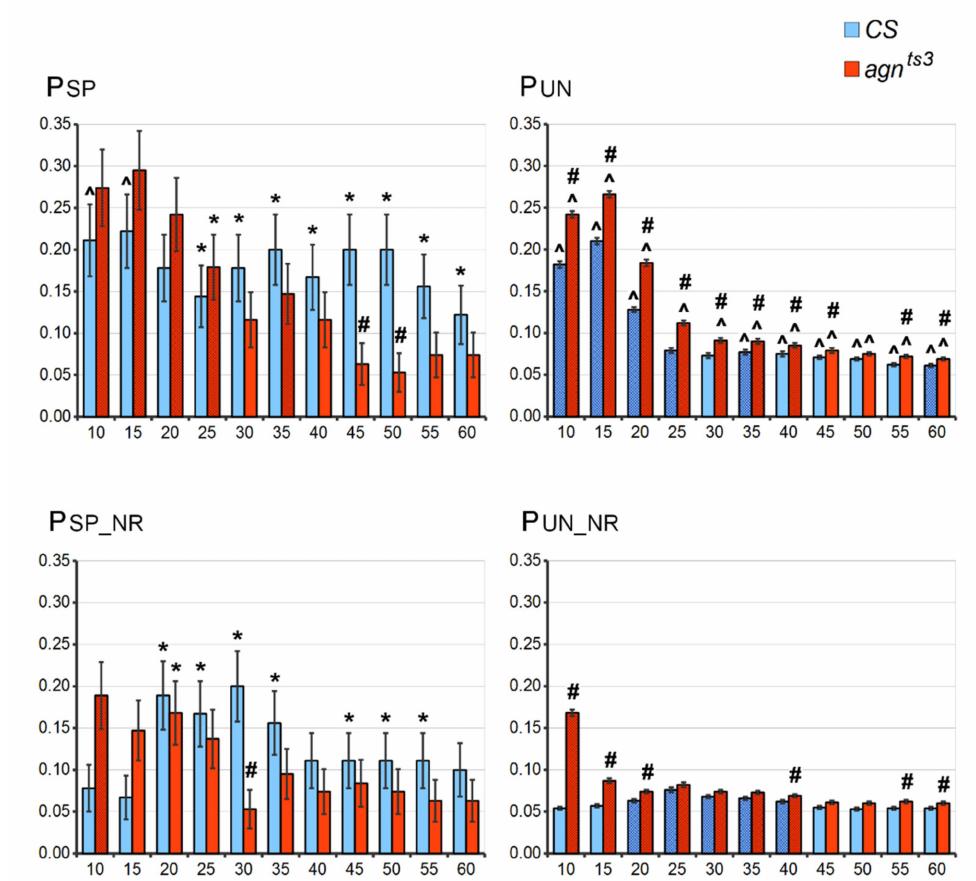
Figure 2. P values at different fragment lengths. X axis: L (nt). Y axis: P (conventional units). Difference: # from CS , ˆ from the case with excluded repeats, * from the case with unspecific correlation, shading- difference from P calculated at L50 (Chi-square test; p < 0.05). Standard error of sample proportion is